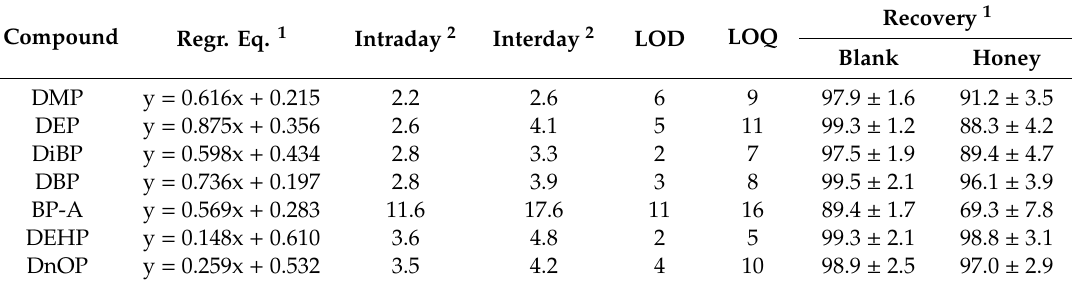
Table 3. Retention time (t r , expressed as min), intraday and interday precision calculated as relative and recovery (%) in blank and honey samples of each PAE and BP-A investigated in this study. Compound Regr. Eq.